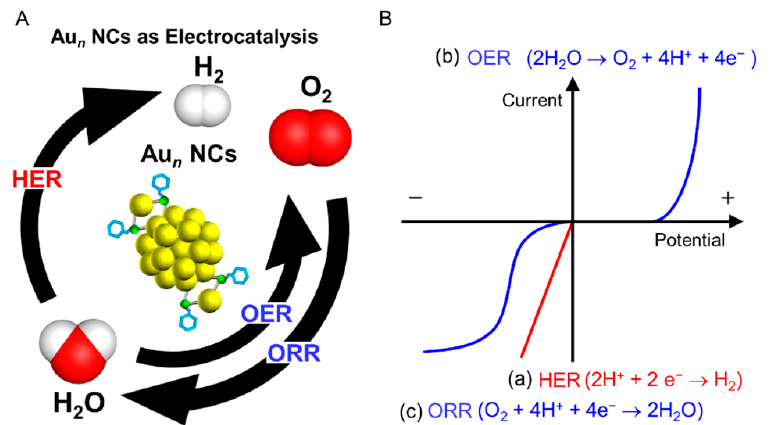
Figure 1. ( A ) Schematic illustration of gold nanoclusters (Au n NCs) for an electrocatalytic reaction in water splitting (hydrogen evolution reaction (HER) and oxygen evolution reaction (OER)) and fuel cells (oxygen reduction reaction (ORR)). ( B ) Current–potential characteristics for (a) HER, (b) OER, and (c) ORR.